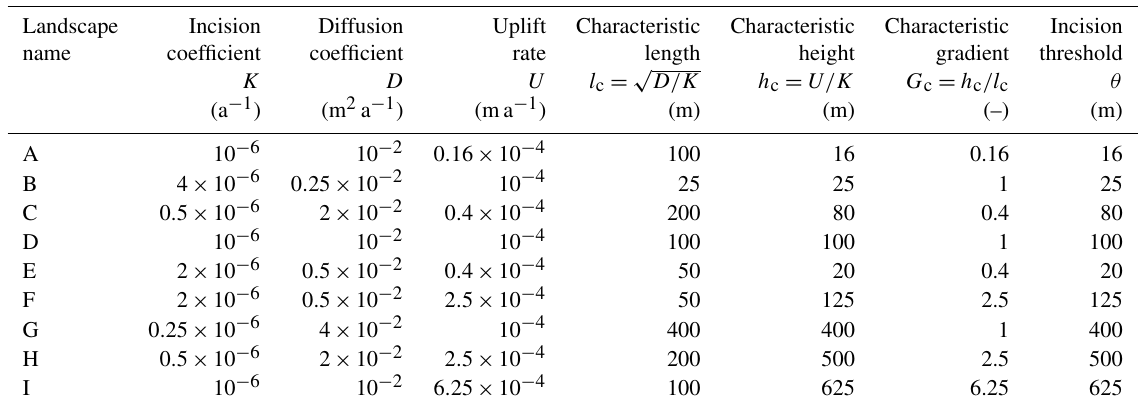
Table 3. Values of parameters ( K , D , U , and θ ) and characteristic scales ( l c , h c , and G c ) of the landscapes described in Sect. 3.1. All landscapes have equal incision-threshold numbers N θ and evolve geometrically similarly. The values of K , D , and U of the landscapes are less than 1 order of magnitude smaller or larger than those of Landscape D, which are typical in the literature (e.g., Perron et al., 2008; Tucker, 2009). Values of incision thresholds θ are such that N θ = Kθ/U = 1. Maps of landscapes A–D are shown in Figs. 1–3. Simulated landscapes with equal incision-threshold numbers: N θ = Kθ/U = 1 Landscape Incision Diffusion Uplift Characteristic Characteristic Characteristic Incision name coefficient coefficient rate length height